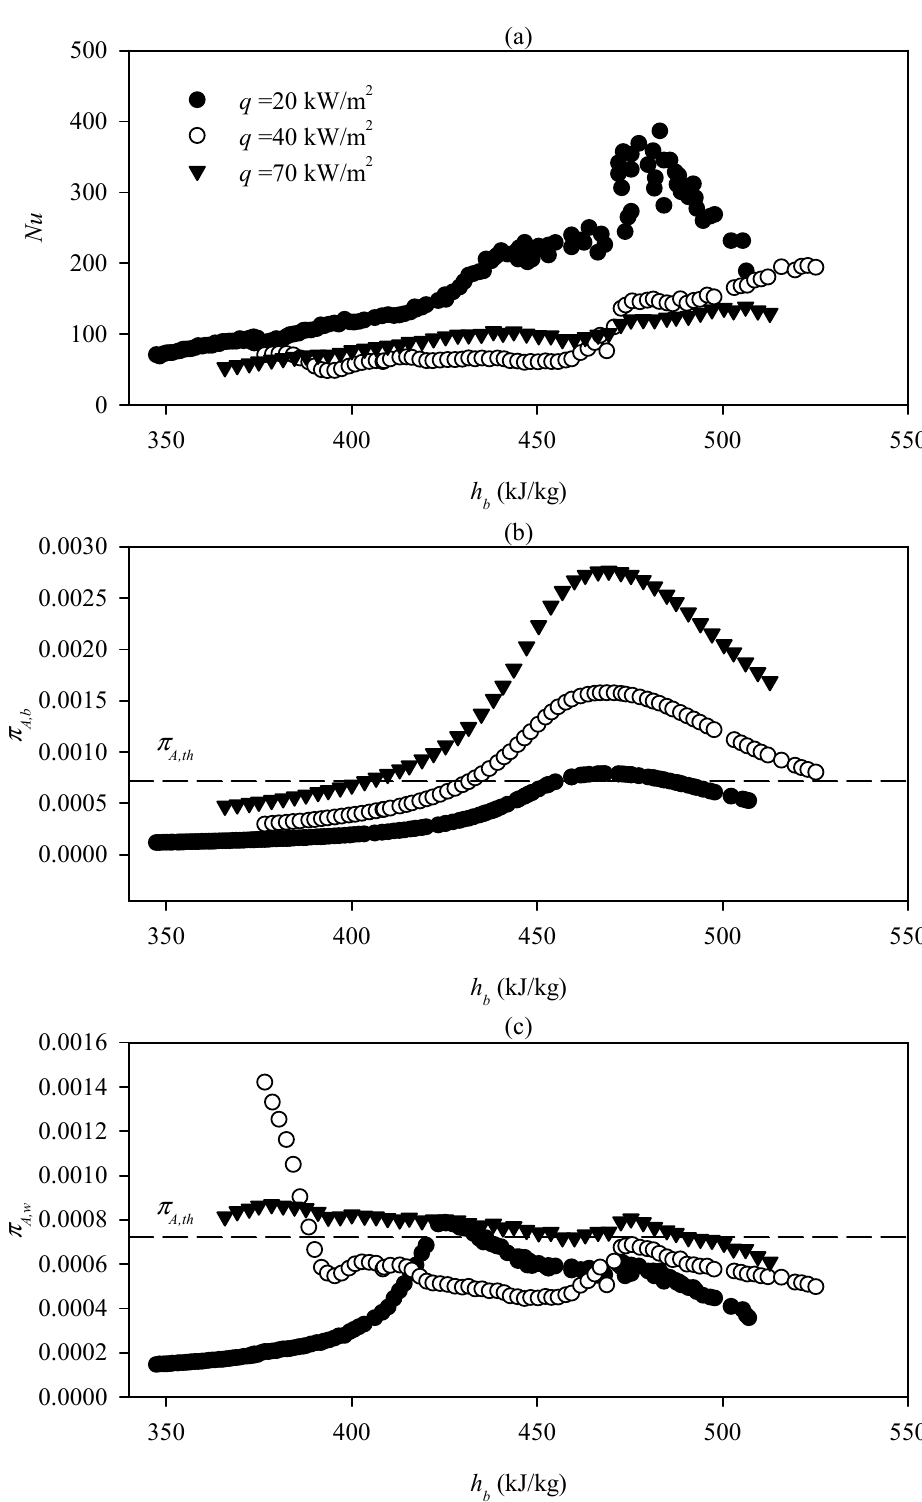
Figure 8. ( a ) Nusselt number, ( b ) π A at both bulk and ( c ) wall condition vs. enthalpy for R-245fa at mass flux of 400 kg / m 2 · s subject to heat fluxes [17].